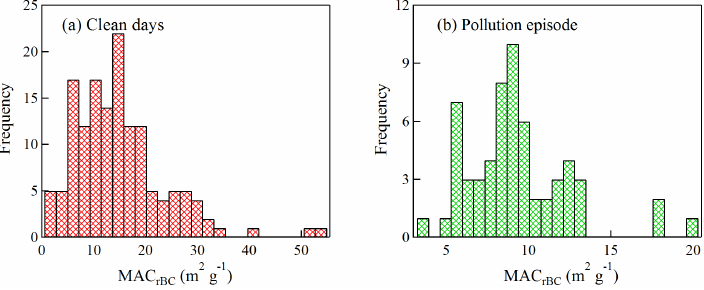
Figure 6. Frequency distributions of rBC mass absorption cross section (MAC rBC ) during (a) clean days and (b) the pollution episode.